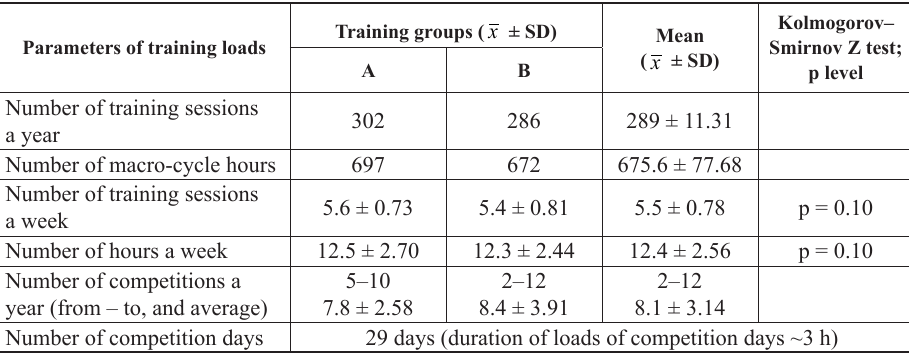
Table 3. Content (%) of training loads of different training programs of 14- 15 year old athletes in rhythmic